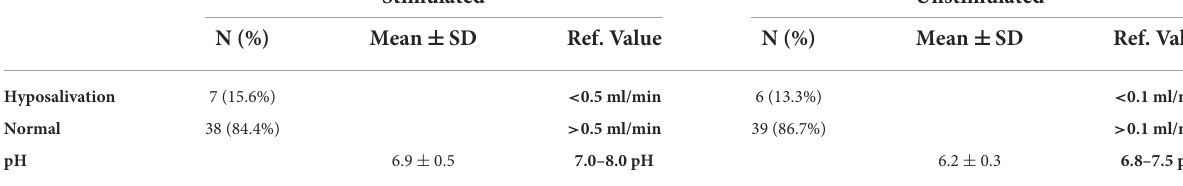
TABLE 5 Salivary flow classification.